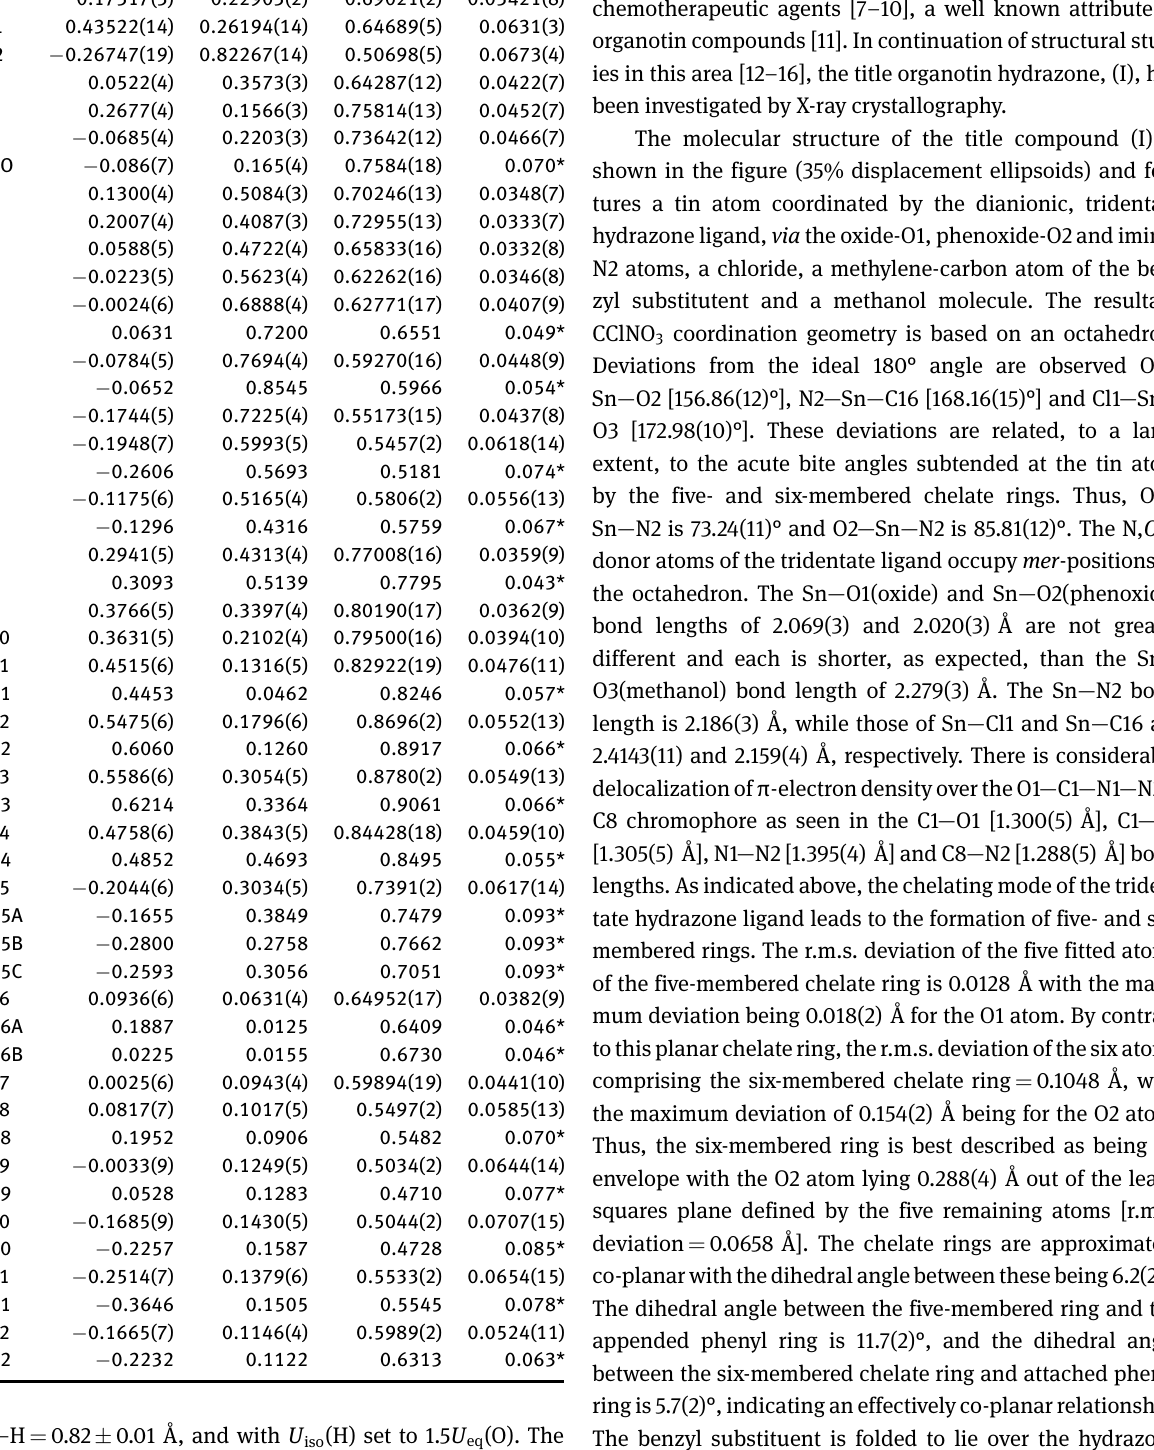
O—H = 0.82 ± 0.01 Å, and with U absolute structure was determined based on differences in Friedel pairs